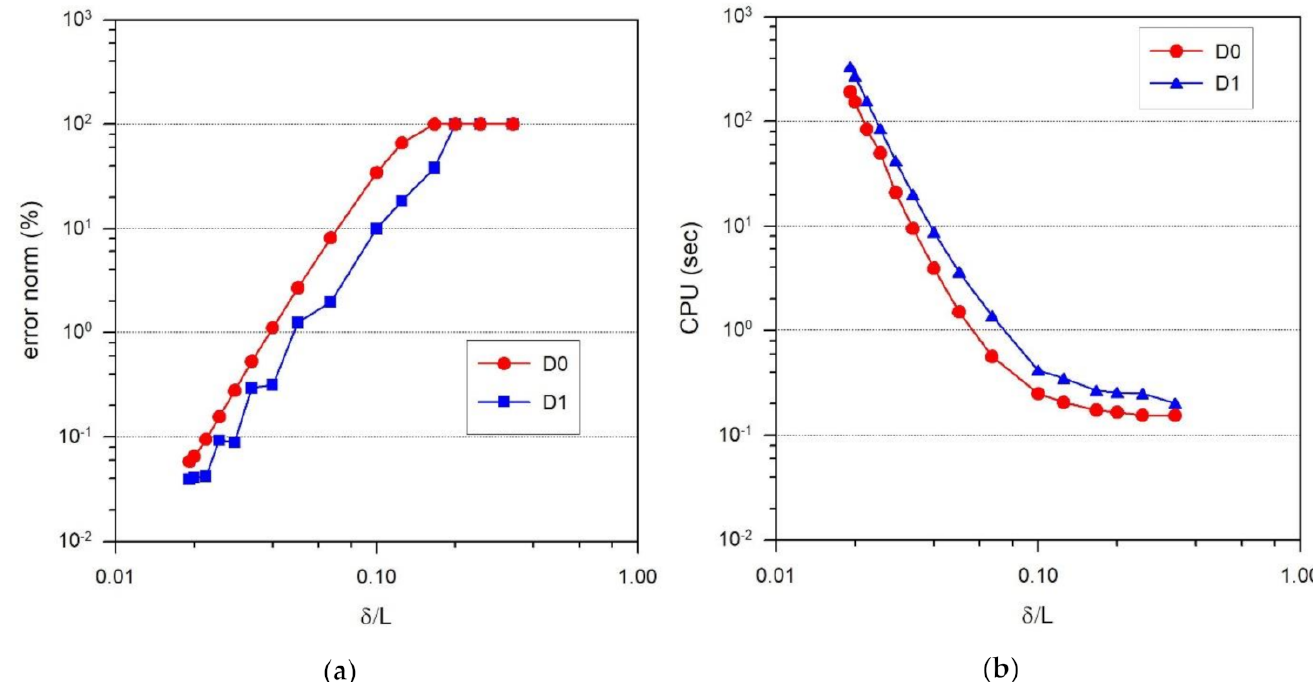
Figure 3. ( a ) Comparison of convergence rates in the homogeneous elastic plate; ( b ) computational efficiency of proposed meshless method for both the differentiation